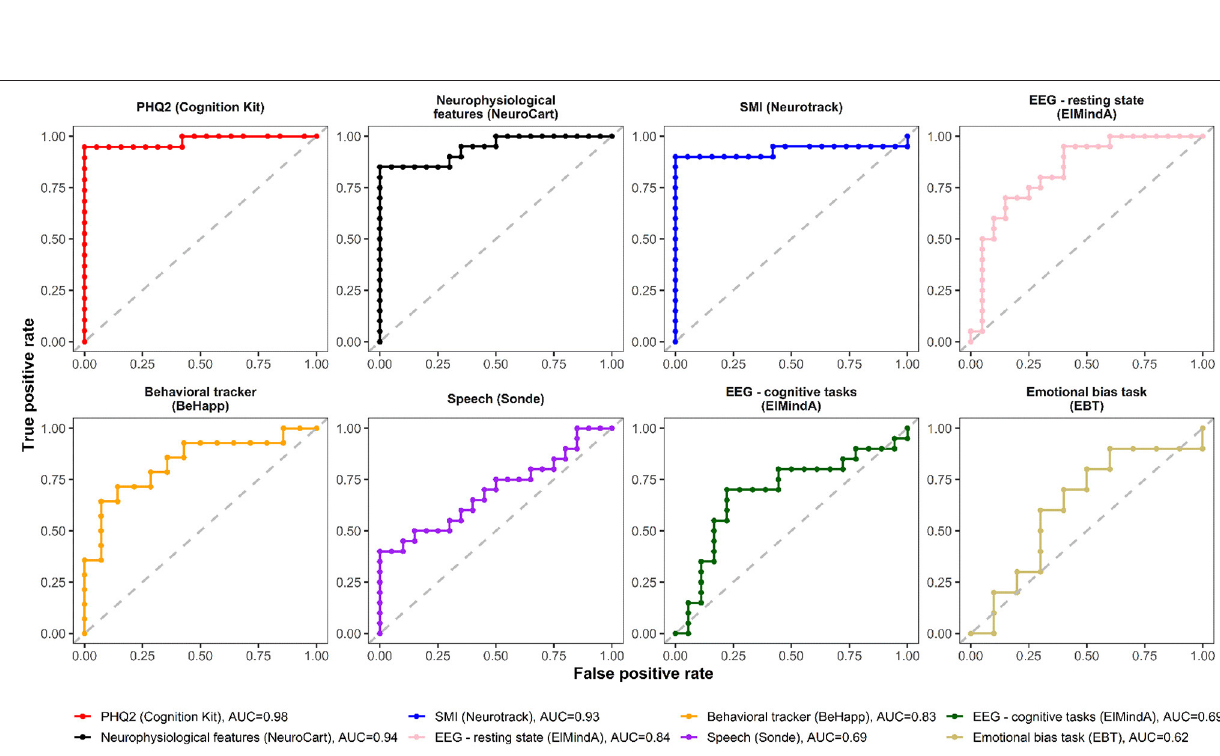
Frontiers in Psychiatry |